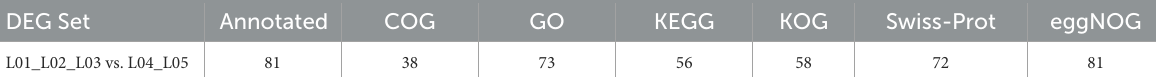
TABLE 10 Statistical table of source genes of annotated circRNA.